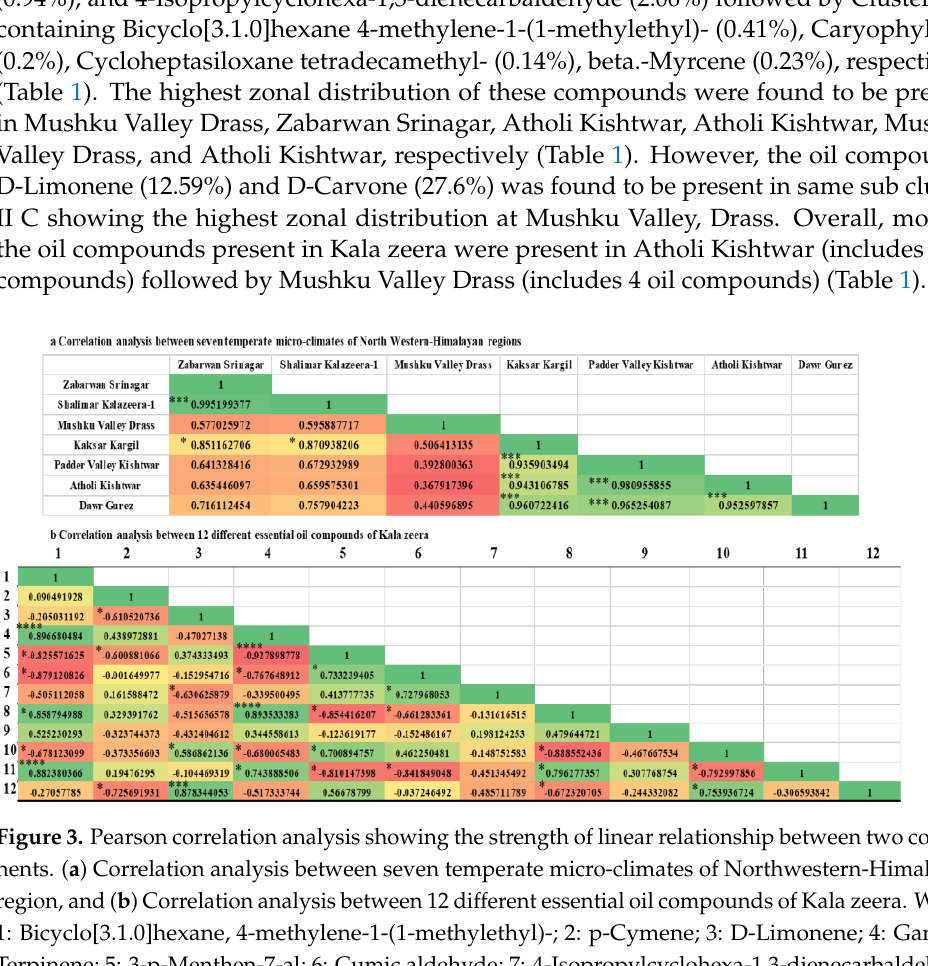
Figure 3. Pearson correlation analysis showing the strength of linear relationship between two com- ponents. ( a ) Correlation analysis between seven temperate micro-climates of Northwestern-Hima- layan region, and ( b ) Correlation analysis between 12 different essential oil compounds of Kala